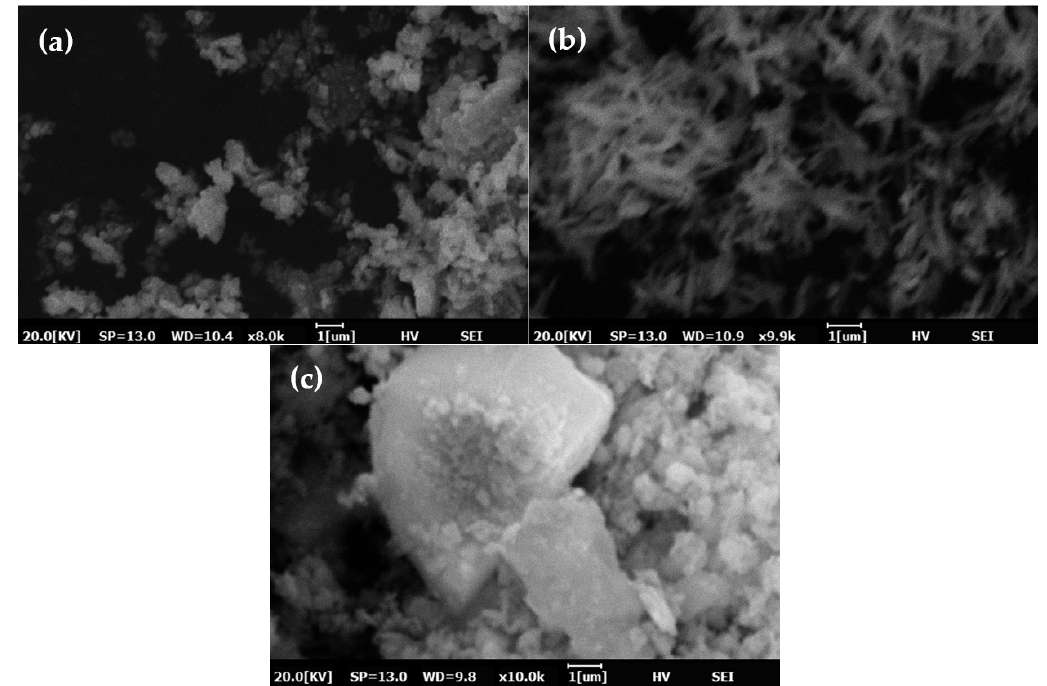
Figure 2. SEM images of ( a ) Hema, ( b ) Goe, and ( c ) Kao.